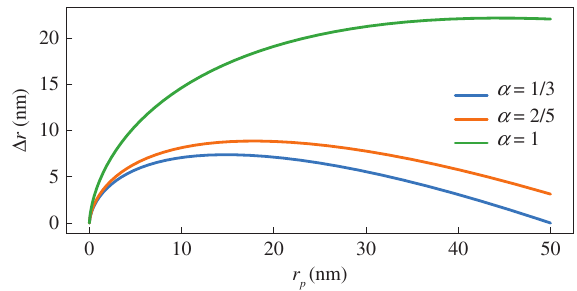
Figure 7: Calculated gain in radius when melting a pillar with a height of 200 nm into a sphere for different form